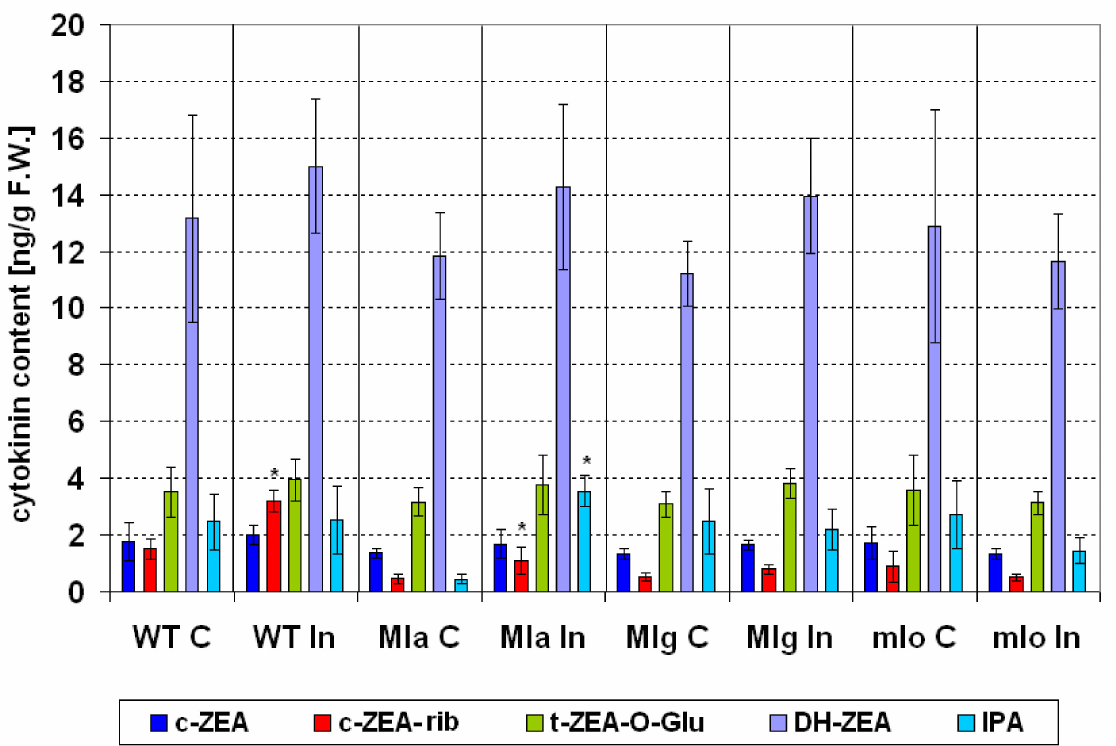
Figure 5. Changes in the contents of five cytokinins in leaves of the susceptible barley cultivar Ingrid and its three near-isogenic lines Mla, Mlg, and mlo at seven days following powdery mildew inoculation (7 dpi). Abbreviations: C, control; In, powdery mildew inoculated; WT, wild type cultivar Ingrid. Investigated hormones: cis -zeatin (c-ZEA, active form), cis -zeatin riboside (c-ZEA-rib, transport form), trans -zeatin-O-glucoside (t-ZEA-O-Glu, degradation form), dihydrozeatin (DH-ZEA, transport form) and N6-isopentenyladenine (IPA, precursor form). Means of five independent repetitions ± SD are shown. The symbol * shows significant di ff erences between inoculated and control leaves ( p < 5%, Student t test) for each genotype (and for particular cytokinin)